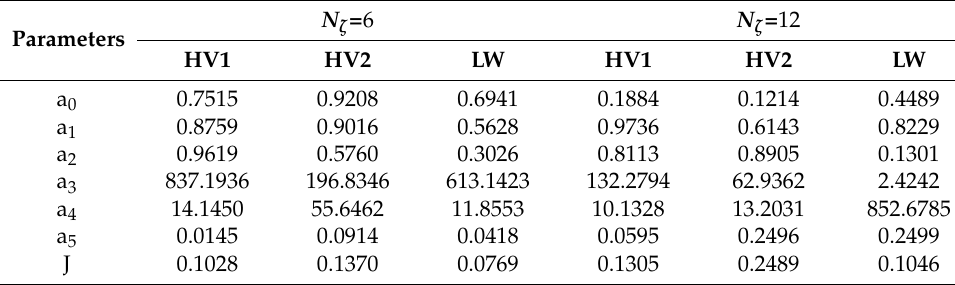
Table 4. Results of the searched parameters and fitness values.